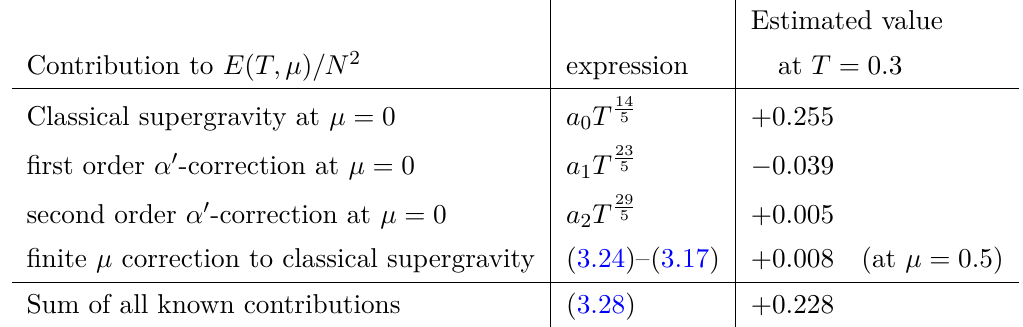
Table 1 . Contributions to E ( T, µ ) /N 2 in the large N limit rounded to the third digit after the decimal point. Uncertainties from the estimations of a 1 and a 2 were ignored due to their smallness and thus irrelevance to the argument. We used the values of a 1 and a 2 obtained in ref. [13] by fitting the simulation results at T ≥ 0 . 4